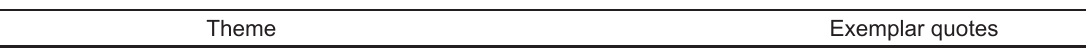
Table 3. Fears and concerns related to emergency care of older adults and their treating clinicians. Question #1 – Fears and concerns about healthcare in the